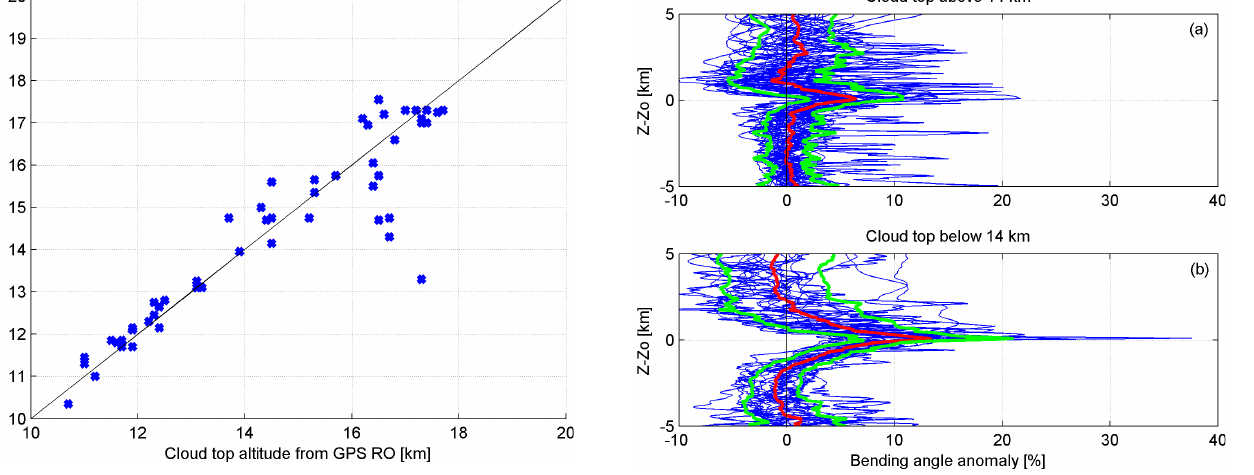
Fig. 7. Vertical profile of the GPS bending angle anomaly, calcu- lated with respect to the altitude of the cloud top derived from the corresponding CALIOP measurements. Blue lines show each of the 53 cases, separated according to cloud top above and below 14km. The red line is the average and the green lines are the average ± one standard deviation.